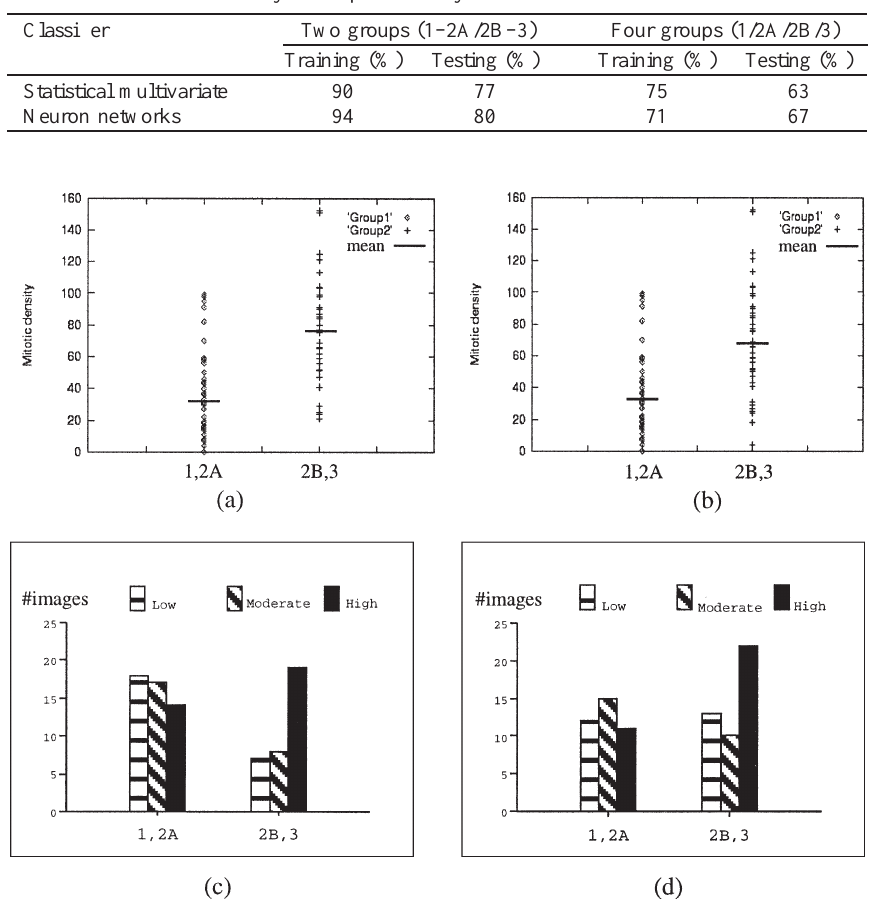
Fig. 8. Two groups: (a) Mitotic density related to subjective grading. Difference of mean is significant at p < 0 . 01. (b) Mitotic density related to computer grading. Difference of mean is significant ( p < 0 . 01). (c) p53 expression classes (low, moderate, high) related to subjective grading. (d) p53 expression classes (low, moderate, high) related to computer